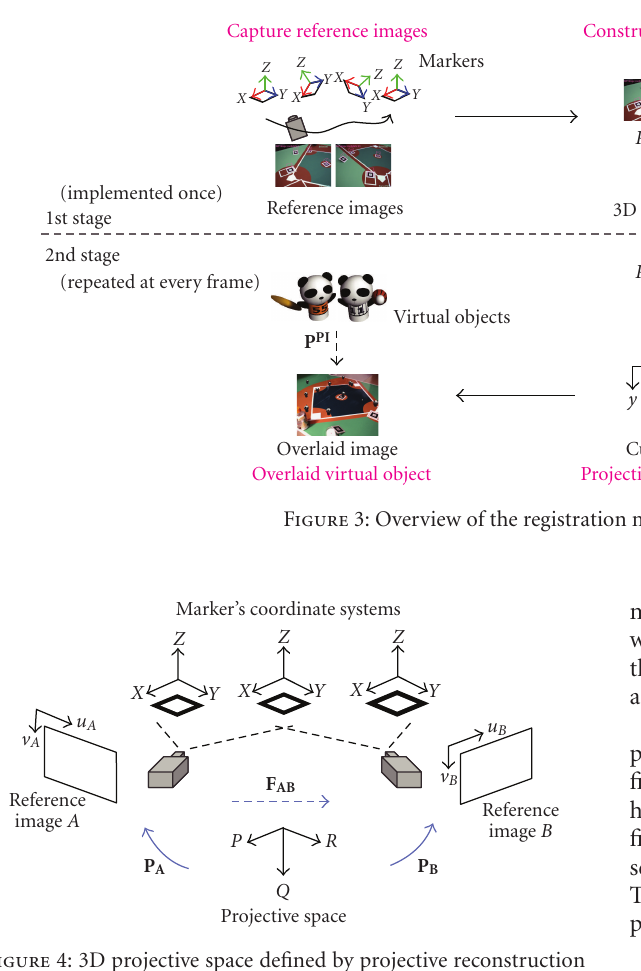
Figure 4: 3D projective space defined by projective reconstruction of the reference